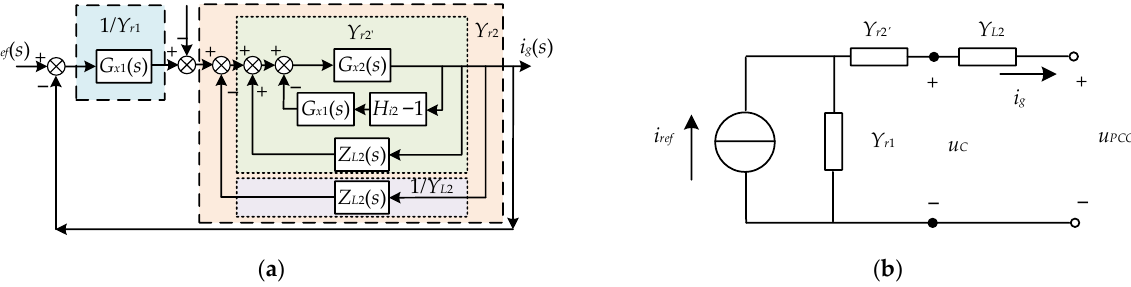
Figure 6. The establishment of the triple decomposed conductance model: ( a ) The triple decomposition conductance small signal model; ( b ) The two-port equivalent model under triple decomposition conductance.